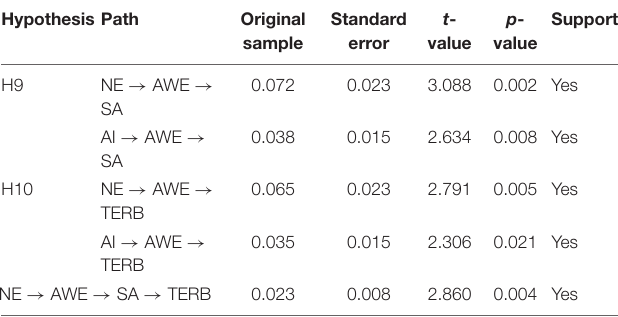
TABLE 5 | Hypotheses tests of the mediating